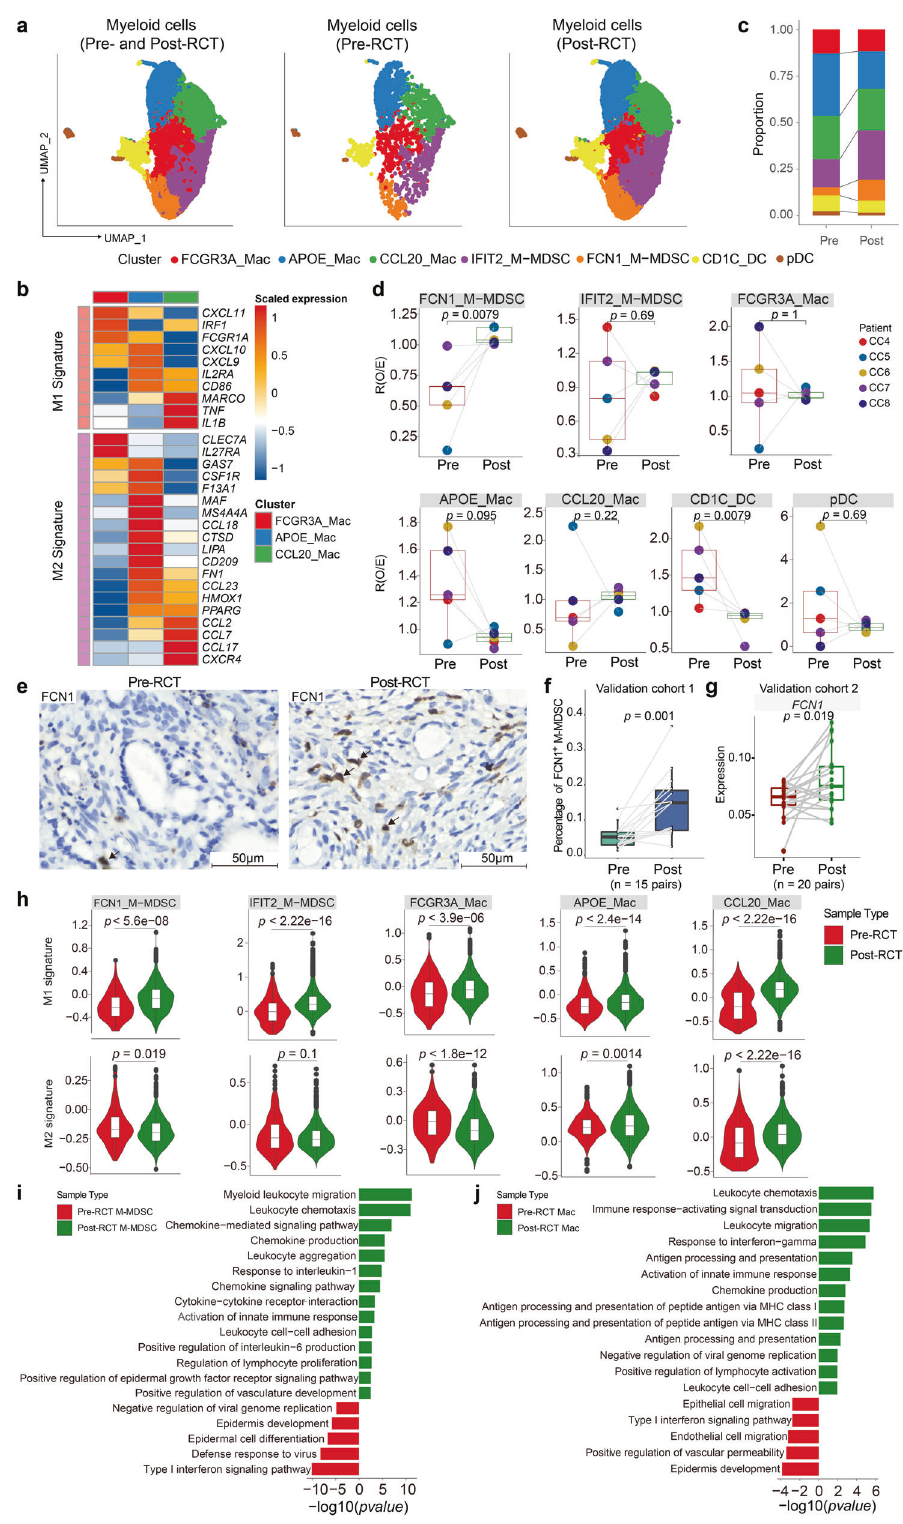
(Fig. 5b, c). Evaluating the expression of signature genesets in CAF subclusters (Fig. 5d and Supplementary Fig. 8d), we found reduced angiogenic features and enhanced in fl ammatory scores in CAFs post-RCT (Fig. 5e, f). Speci fi cally, the expression was lower for genesets associated with angiogenesis but higher for genesets